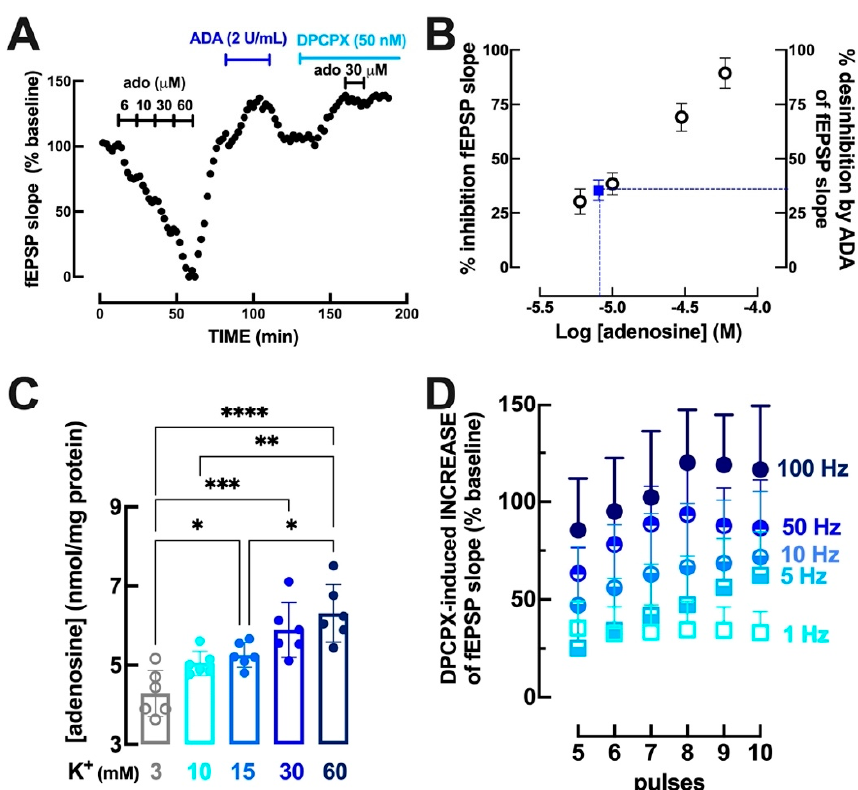
Figure 1. Estimation of the endogenous extracellular levels of adenosine in hippocampal synapses show that the intensity- and frequency-dependent increase in adenosine reaches levels sufficient to block synaptic transmission at higher frequencies of stimulation. ( A ) Representative experiment in a mouse hippocampal slice, showing that increasing concentrations of exogenously added adenosine (Ado, 6–60 µM) caused an increased inhibition of hippocampal synaptic transmission, measured as a decrease in the slope of field excitatory postsynaptic potentials (fEPSP) recorded in the CA1 stratum radiatum upon stimulation of the afferent Schaffer collaterals with pulses delivered at 0.1 Hz. The effect of adenosine is essentially abolished by the selective A 1 R antagonist DPCPX (50 nM) and both DPCPX and adenosine deaminase (ADA, which convert extracellular adenosine into inosine) increase fEPSP responses, implying that endogenous extracellular adenosine tonically depresses hippocampal synaptic transmission. ( B ) The interpolation of ADA-mediated disinhibition on the curve of adenosine-mediated inhibition of synaptic transmission prompts an estimate of synaptic extracellular levels of adenosine of 8 µM. Data are mean ± SEM of n = 6. ( C ) The mean ± SEM values ( n = 6) of the extracellular levels of adenosine, upon incubation of mouse hippocampal synaptosomes ( ∼ 1.2–1.4 mg protein/mL) during 5 min in the presence of increasing concentrations of K + (10–60 mM), showing that there is an increase in adenosine out fl ow proportional to the intensity of potassium-induced synaptic depolarization. * p < 0.05, ** p < 0.01, *** p < 0.005, **** p < 0.001 between indicated bars. ( D ) The e ff ect of DPCPX on hippocampal synaptic transmission in Scha ff er fi bers-CA1 pyramid synapses is larger with increasing frequencies of stimulation, with pulses applied in groups of 10 with increasing frequencies from 1–100 Hz, with 10 min interval without stimulation between each group, fi rst in the absence, then in the presence of 100 nM DPCPX. Data are mean ± SEM values ( n = 4–6).